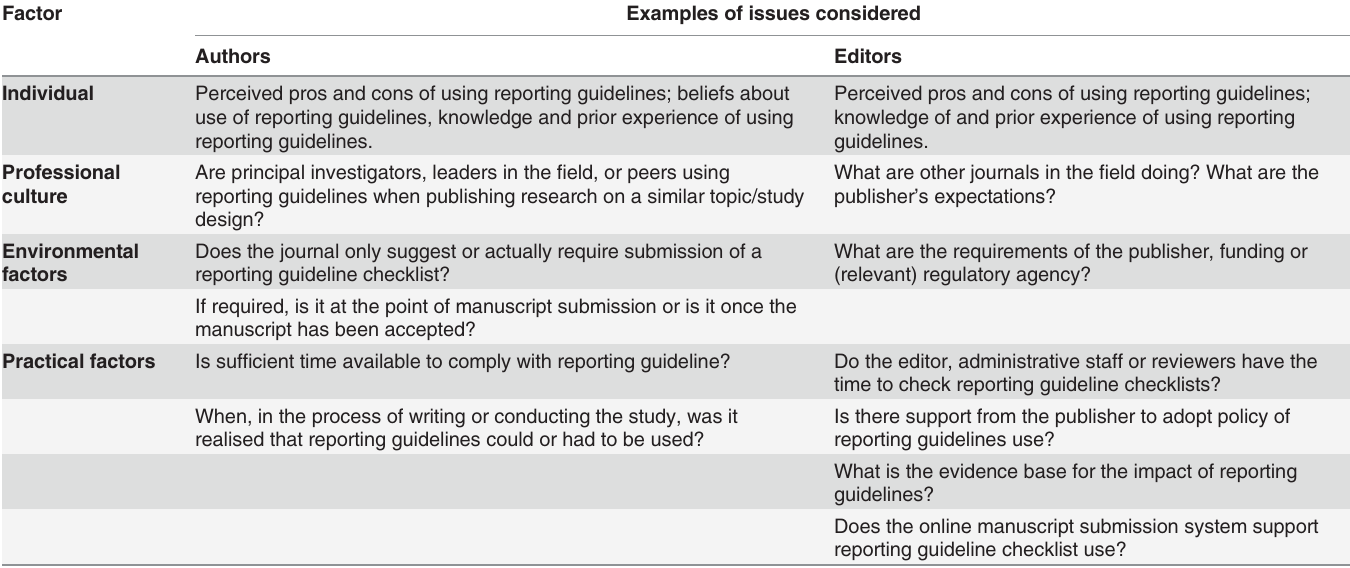
Table 3. Issues faced by authors and editors when considering using reporting